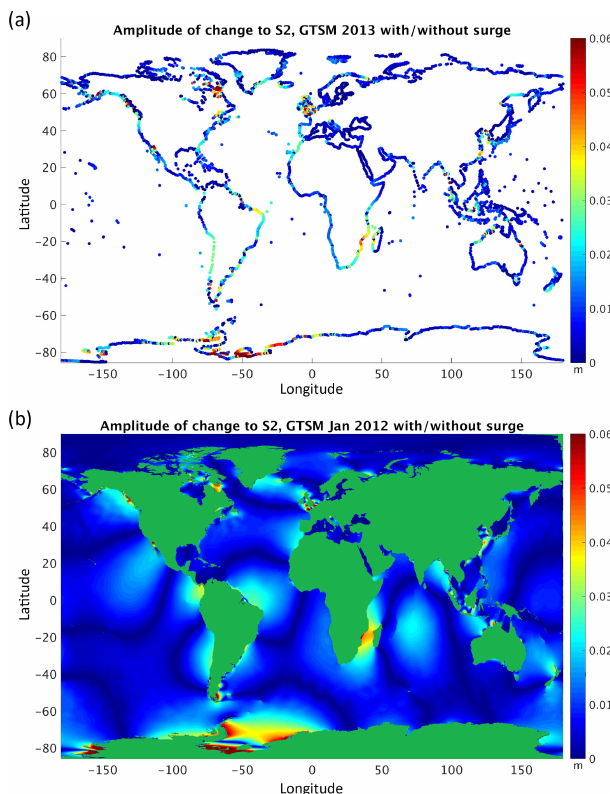
Figure 5. Amplitude (m) of S 2 difference between coefficients fit- ted to the GTSM tide-and-surge ( M s ) or tide-only ( M t ) model. (a) Coastal data only, whole of 2013; (b) 26 primary coefficients fitted to January 2012